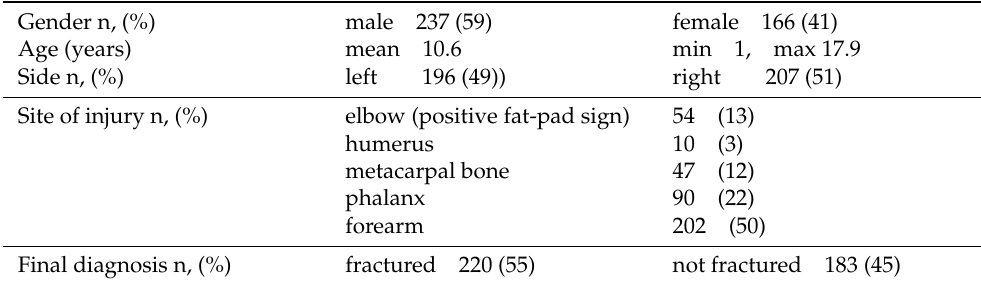
Table 1. Baseline patient characteristics (n = 403).